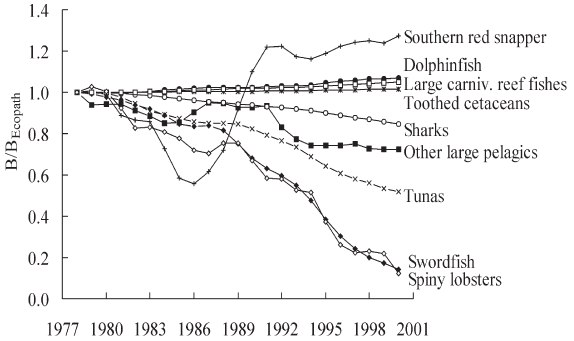
Fig . 5. – Changes in biomass in relation to the Ecopath level (1.0) for some groups included in the 1970s model of the marine ecosys- tem off northeastern Brazil (1978-2000). The remaining groups did not show any changes.